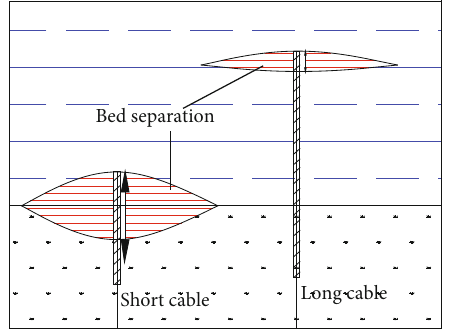
Figure 11: The diagram of “ long+short cables ” support.